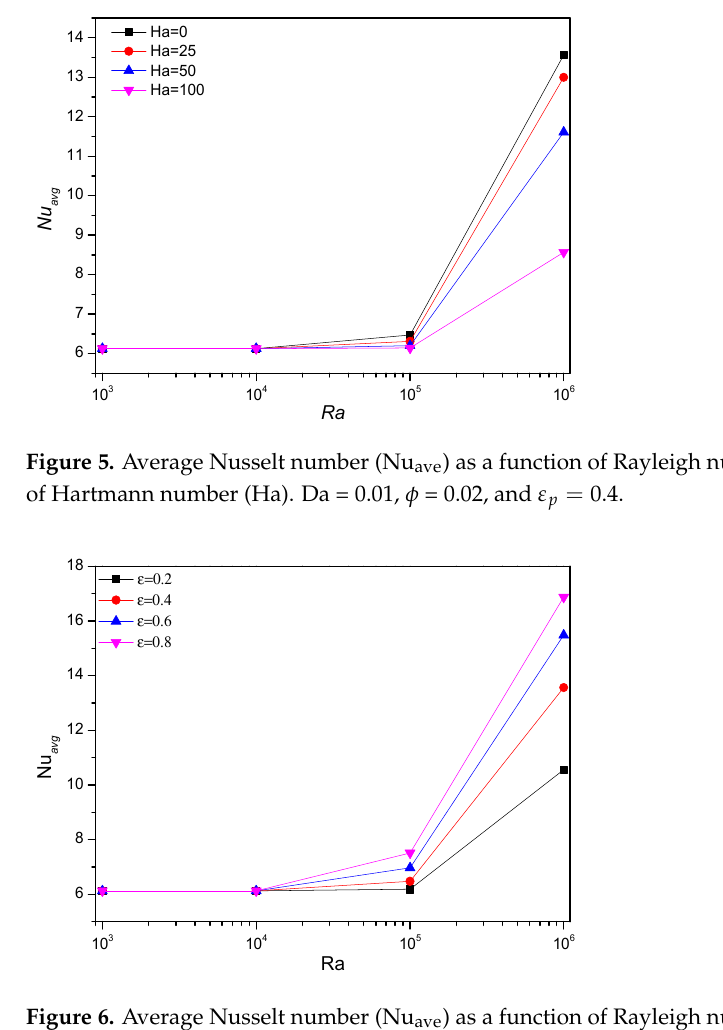
Figure 6. Average Nusselt number (Nu ave ) as a function of Rayleigh number (Ra) at various values of porosity ( ε p ). Ha = 0, Da = 0.01 and φ = 0.02.